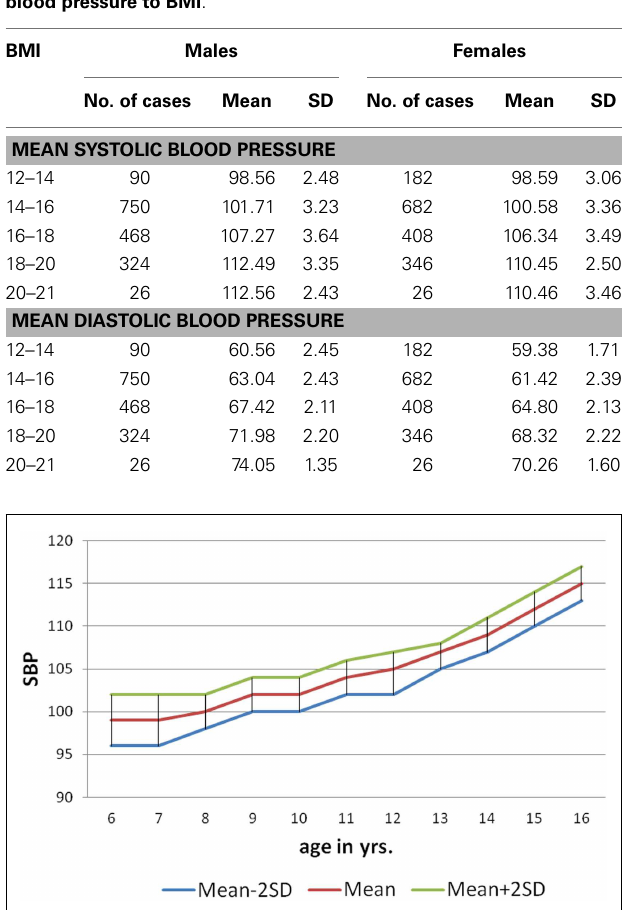
FIGURE 1 | Norms of mean SBP according to age in boys (6–16years) .